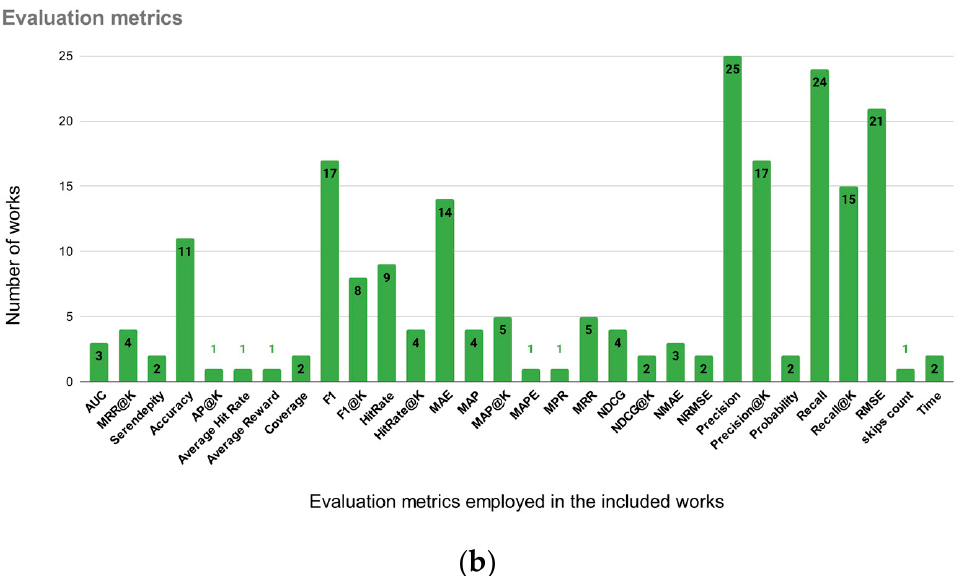
Figure 6. ( a ) Works employing different evaluation protocols ( b ) works employing different evaluation metrics.